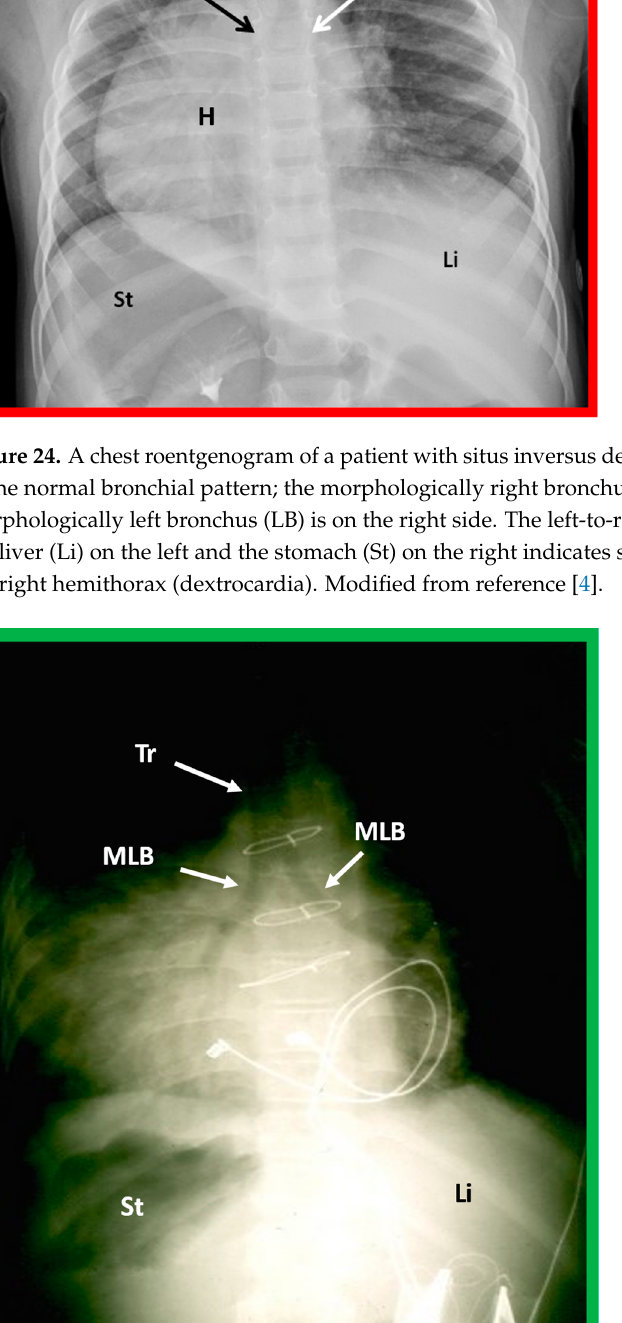
Figure 25. A highly penetrated chest roentgenogram in an anteroposterior view of a child with dextrocardia associated with situs inversus demonstrates bilateral morphologic left bronchi (MLB); the patient was found to have polysplenia syndrome. Sternal wires and pacemaker artifacts (not labeled) from the previous operation are also seen. Li, liver, St, stomach; Tr,